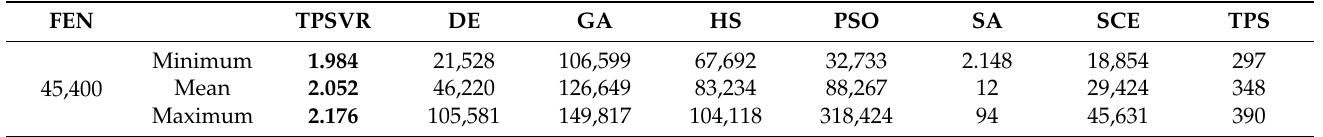
Table 9. Results for the Balerma